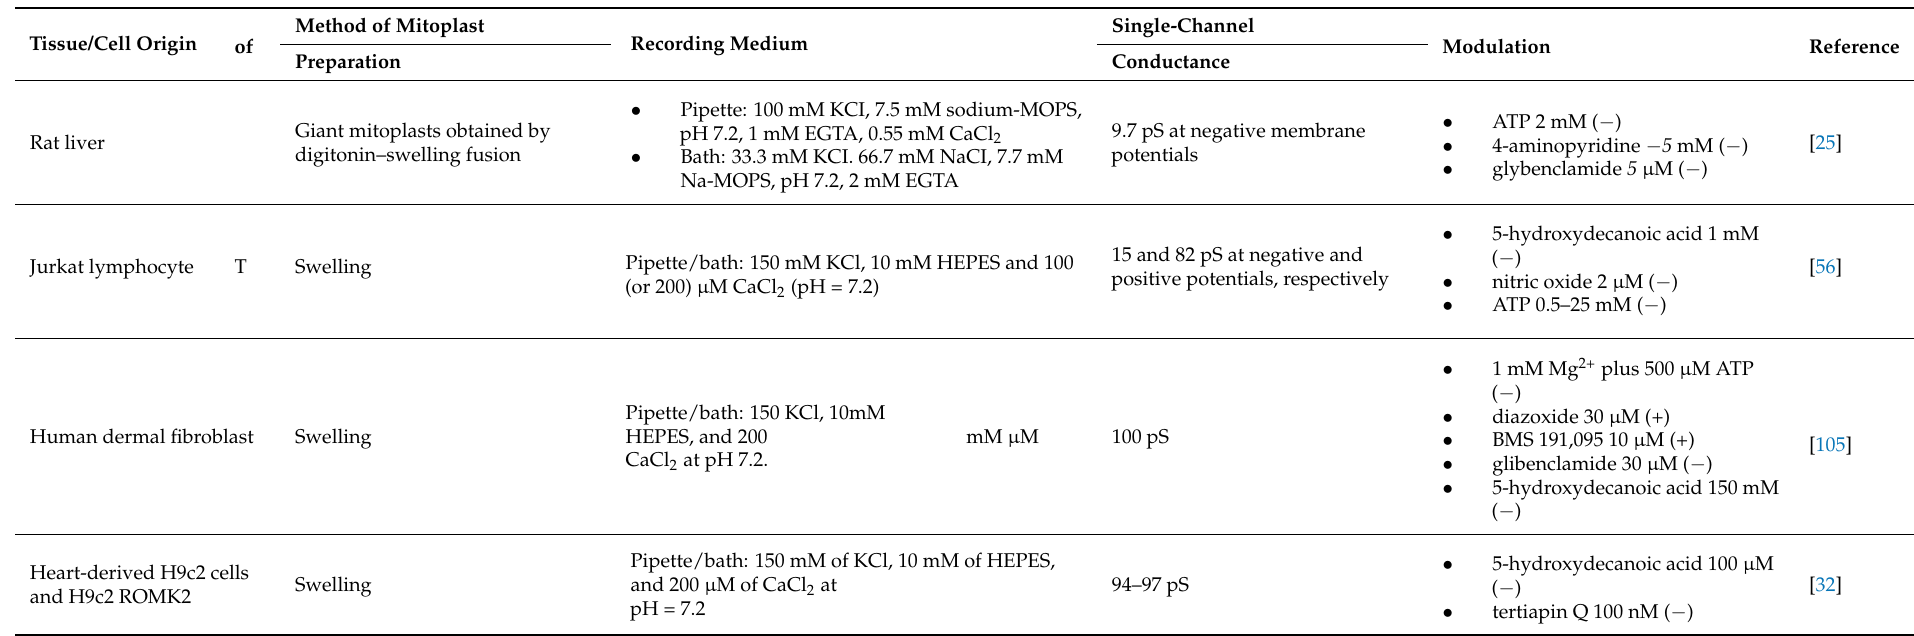
Table 2. Biophysical characteristics of mitoKATP channel activities recorded by patch clamping of the inner mitochondrial membrane (excised inside-out configuration). “+” and “ − ” denote activation or inhibition of mitoKATP,